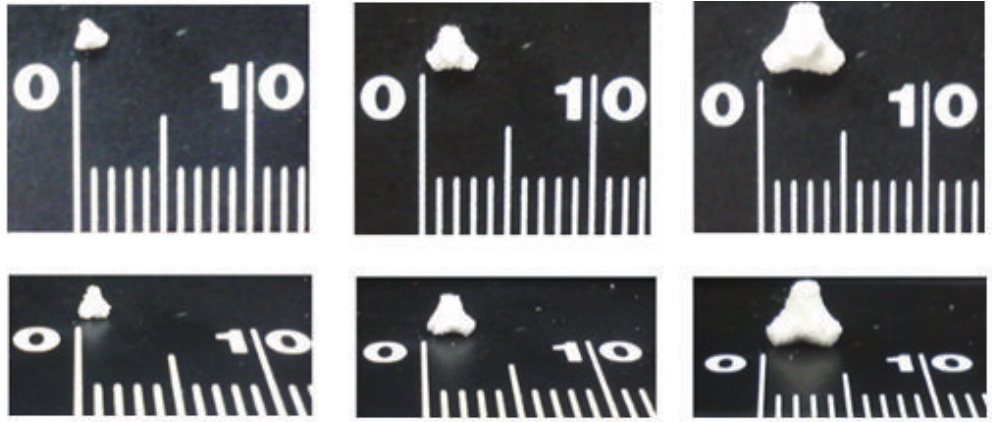
Figure 12: Design of grains inside the proposed holding device.